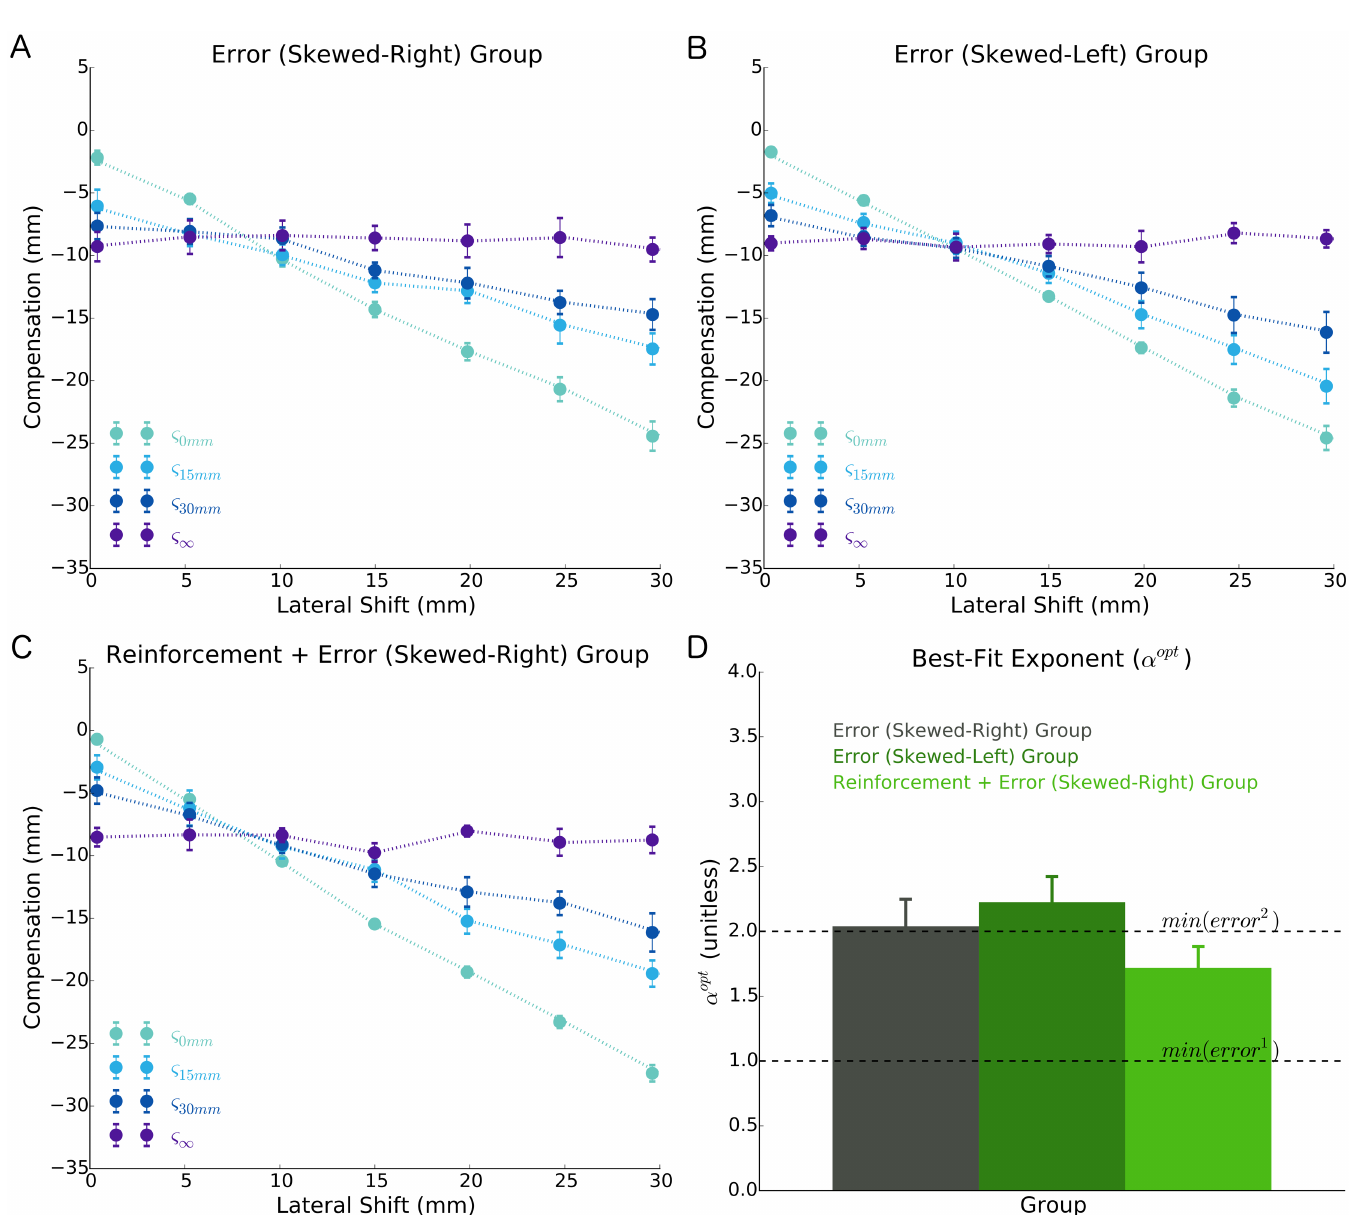
Fig 3. Average pattern of compensation (filled circles) in Experiment 1 to different magnitudesof lateral shift ( x -axes)and visual uncertainty(separate lines) of participants receiving A) error feedbacklaterallyshifted by skewed-right probabilitydistribution, B) error feedbacklaterally shifted by a skewed-left probabilitydistribution (note: these data are ‘flipped’to visuallyalign with the other groups), and C) both reinforcementand error feedbacklaterally shifted by a skewed-right probabilitydistribution. A darker shadeof blue signifies greater visual uncertainty. D) The best-fit power loss-functionexponent ( α opt ) of a Bayesianmodel that, in additionto characterizing how error was minimized,was also a sensitive metric to whetherparticipantswere influenced by reinforcement feedback(see Methods). An exponent of 2.0 corresponds to minimizing squarederror (upper dashedline), while an exponent of 1.0 correspondsto minimizingabsoluteerror (lower dashedline). We found no significantdifferencesin either the compensation( p = 0.956) or α opt ( p = 0.187) betweengroups. These findings suggestthat all groups minimizedapproximately squarederror, and that the sensorimotor system heavilyweights error feedbackover reinforcement feedbackwhen both forms of feedbackare available.Error bars represent ± 1 standard error of the mean. https://doi.org/10.1371/journal.pcbi.1005623.g003 PLOS Computational Biology | https://doi.org/10.1371/journal.pcbi.1005623 July 28,